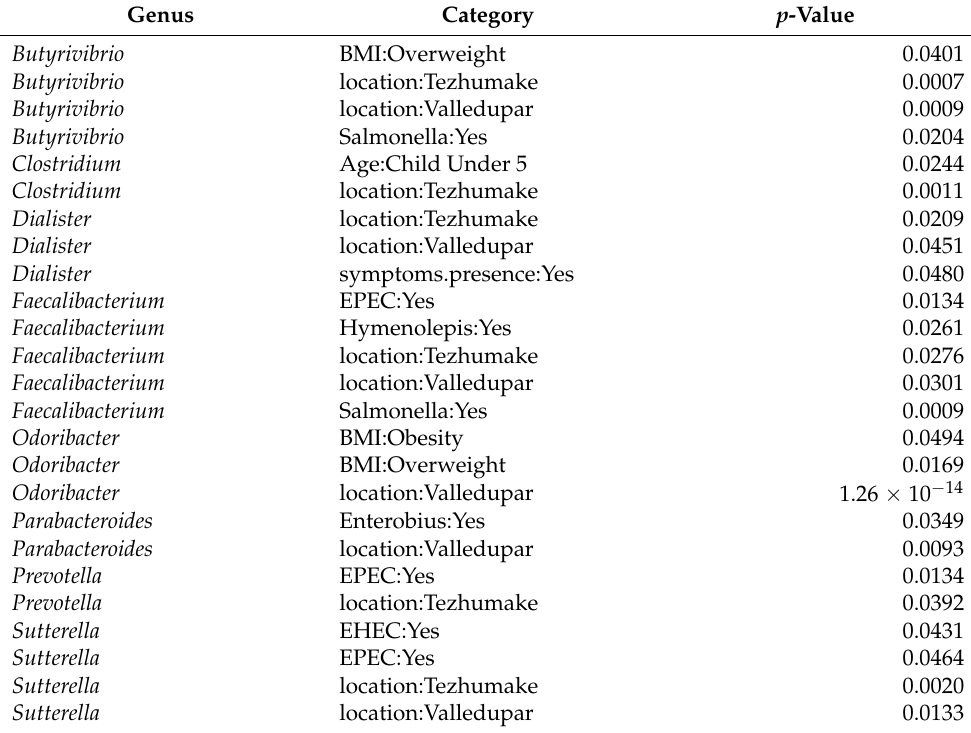
Table 2. Genera significantly associated with demographic and clinical data. OTU genera abundances (log10-corrected) were combined with demographic and clinical data (“category”) and evaluated through generalized mixed linear models. Results are shown for genera under the significance cutoff ( p -value <